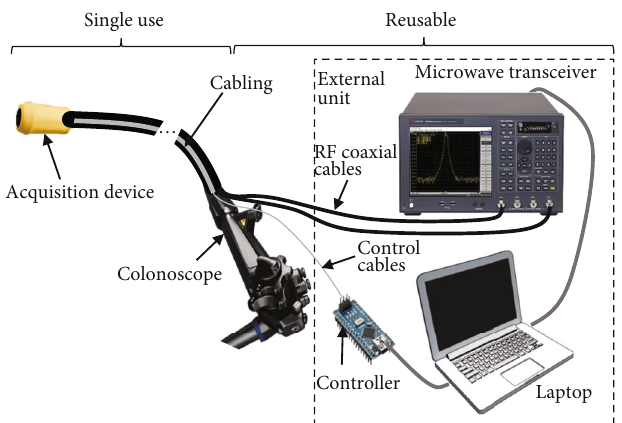
Figure 1: The imaging system consists of a cylindrical ring-shaped acquisition device attached to the tip of a colonoscope connected via cables to the external unit. The external unit consists of a microwave transceiver, a microcontroller, and a laptop.